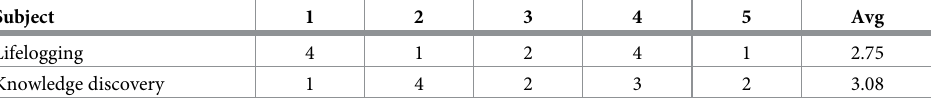
Table 4. Number of survey respondents by whether or not they used specific features of the application. Feature Yes No Not sure Created a collaboration 11 1 0 Created a dataset 11 1 0 Imported data into a dataset 10 2 0 Added a dataset to a collaboration 10 2 Searched for experts 9 Sent an invitation to an expert Added an expert to a collaboration 10 0 Reviewed a data request 9 3 0 Granted a data request 9 3 0 Attached privacy constraints to a data request 3 8 1 Downloaded analysis results 9 3 Viewed a visualization Opened the chat window Sent a chat